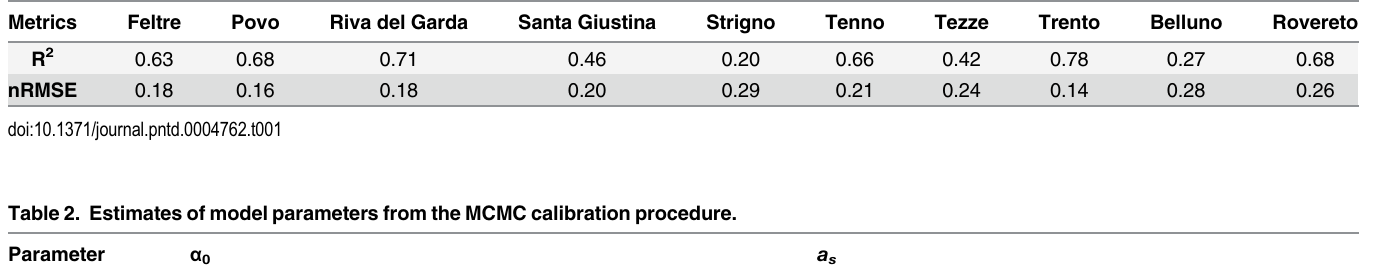
Table 1. Metrics for the goodness of fit between predicted and observed mosquito abundances.